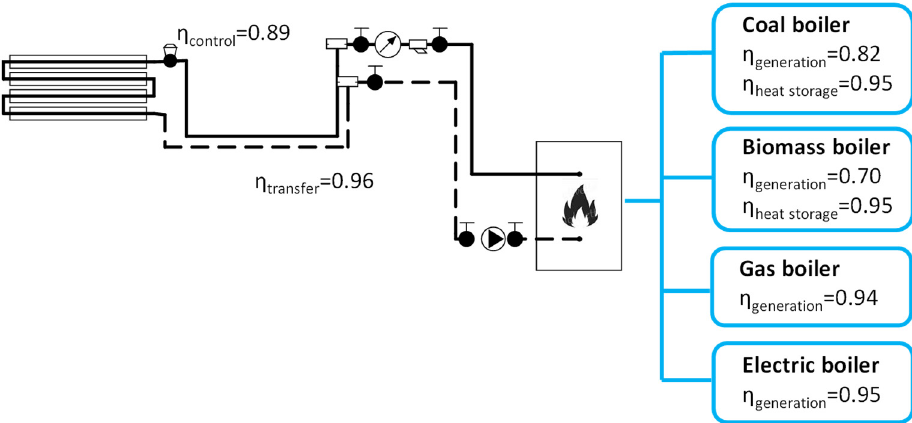
Figure 2. Heating sources considered and efficiency of the heating system.